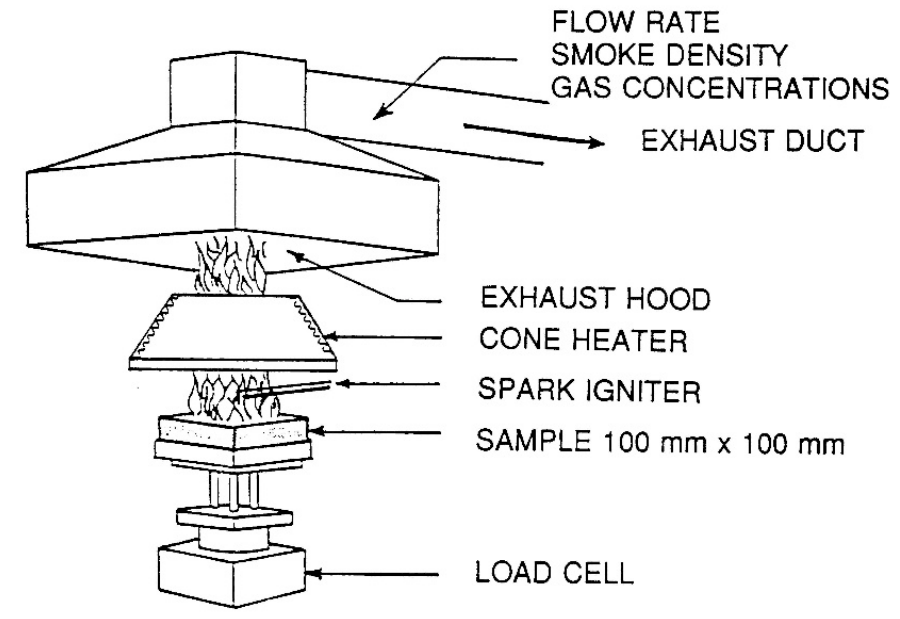
Figure 1. Fire testing using the cone calorimeter ISO 5660-1 (a schematic picture).